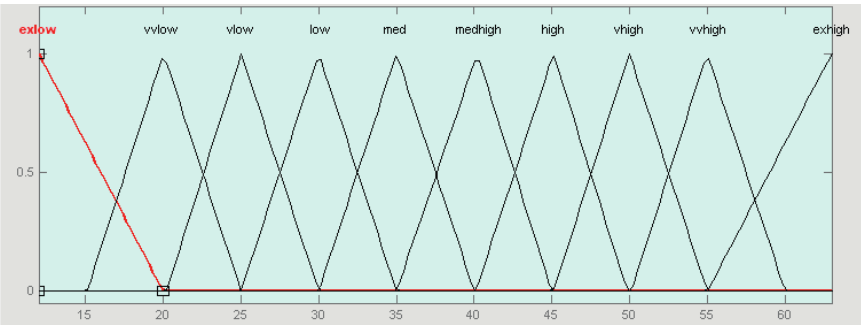
Figure 2. Fuzzy output membership functions of the crop